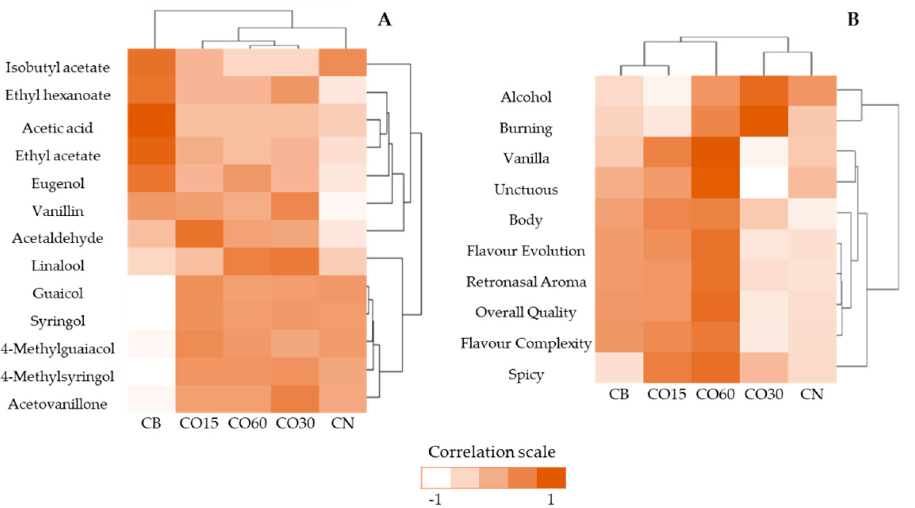
Figure 2. Heatmaps of volatile compounds ( A ) and sensory characteristics ( B ) of wine spirits and ageing modalities at 365 days of ageing.